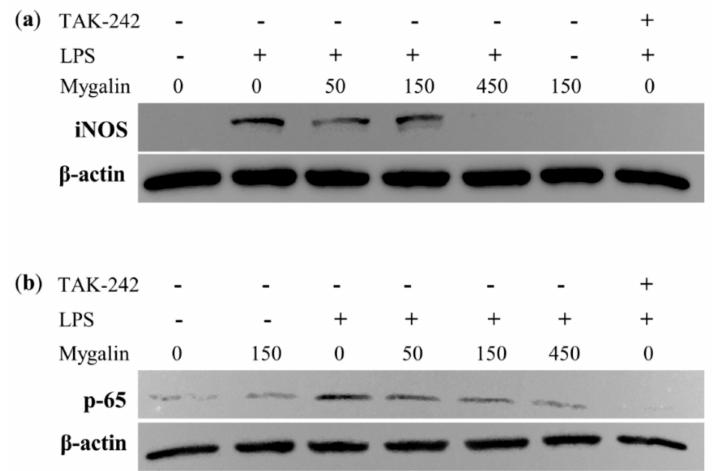
Figure 10. E ff ects of mygalin on LPS-induced. ( a ) inducible nitric oxide synthase (iNOS) and ( b ) NF- κ B p65 protein expression by SDS-PAGE. Western blotting was performed using specific antibodies against iNOS and NF- κ B p65 (Cell Signaling). TAK-242 was used as a TLR4 signal